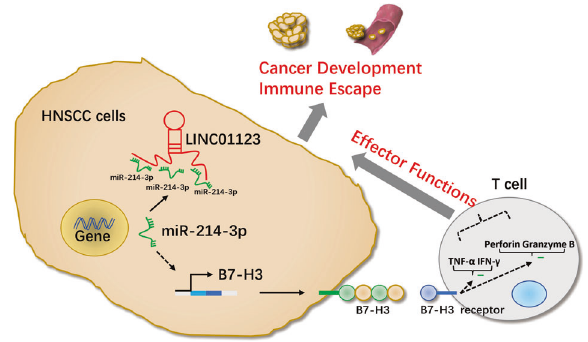
Fig. 7 Molecular role of LINC01123 in regulating the progression and immune escape of